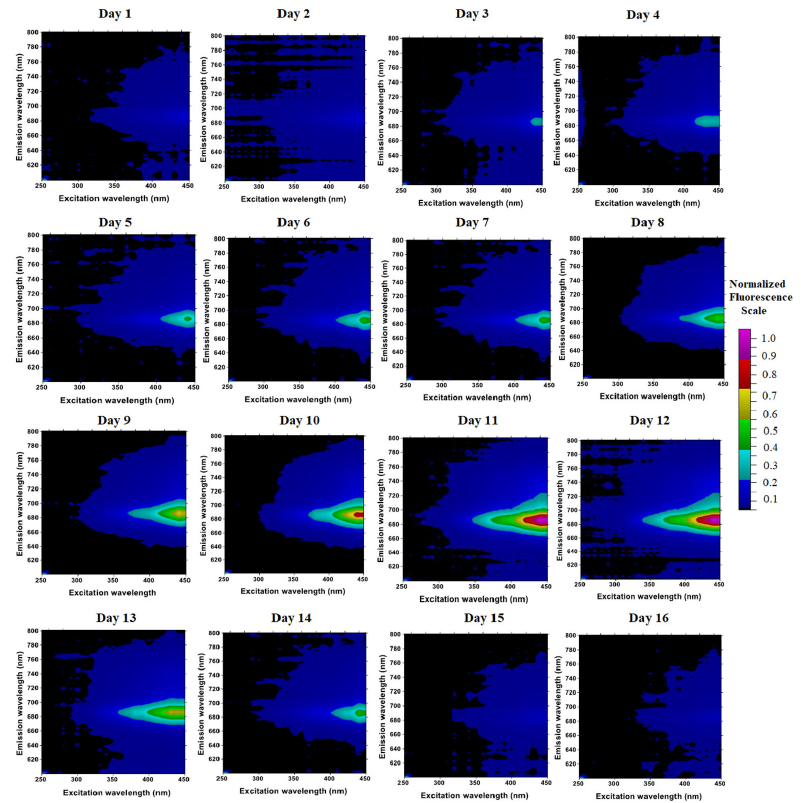
Figure 4. EEM measurements of C. reinhardtii during the 16-day sampling period. Single fluorescence peak was observed in each EEM. The low ‐ temperature fluorescence spectra were analyzed, showing different bands. As observed, C. reinhardtii exhibited a major peak range from 680 to 685 nm, which corresponds to protein complexes (LHCII and PSII core) [38]. Using two ‐ way ANOVA, no significant differences were observed at OD650, OD680 and OD700; hence, an optical density at 680 nm was used for correlation between parameters [39]. Figure 5 shows the measured OD680 and peak signal from the EEM fluorescence of C. reinhardtii .